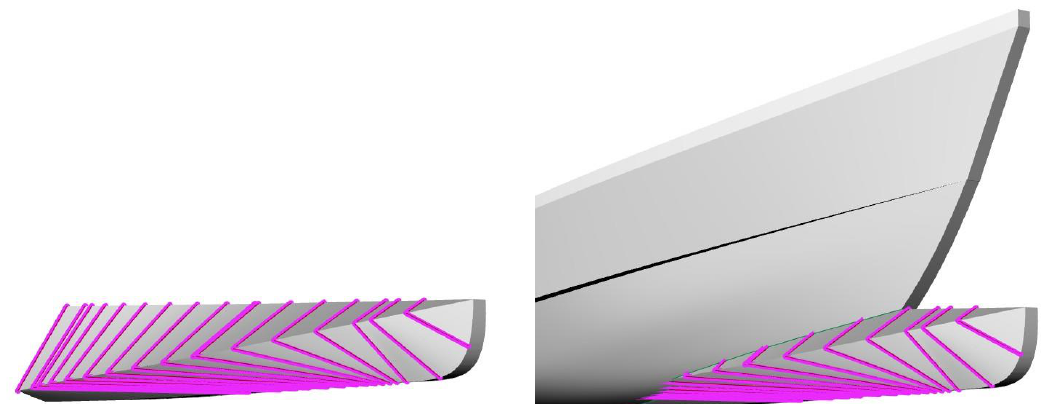
Figure 7. Rulings in a dihedral bow.